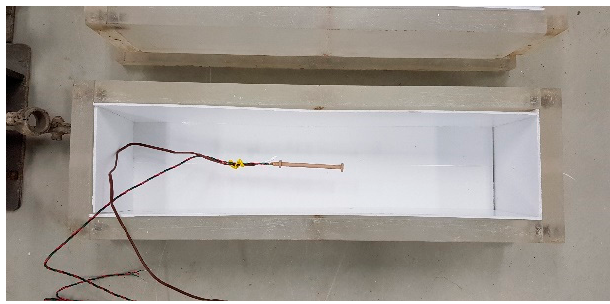
Figure 1. Measurement of length change.